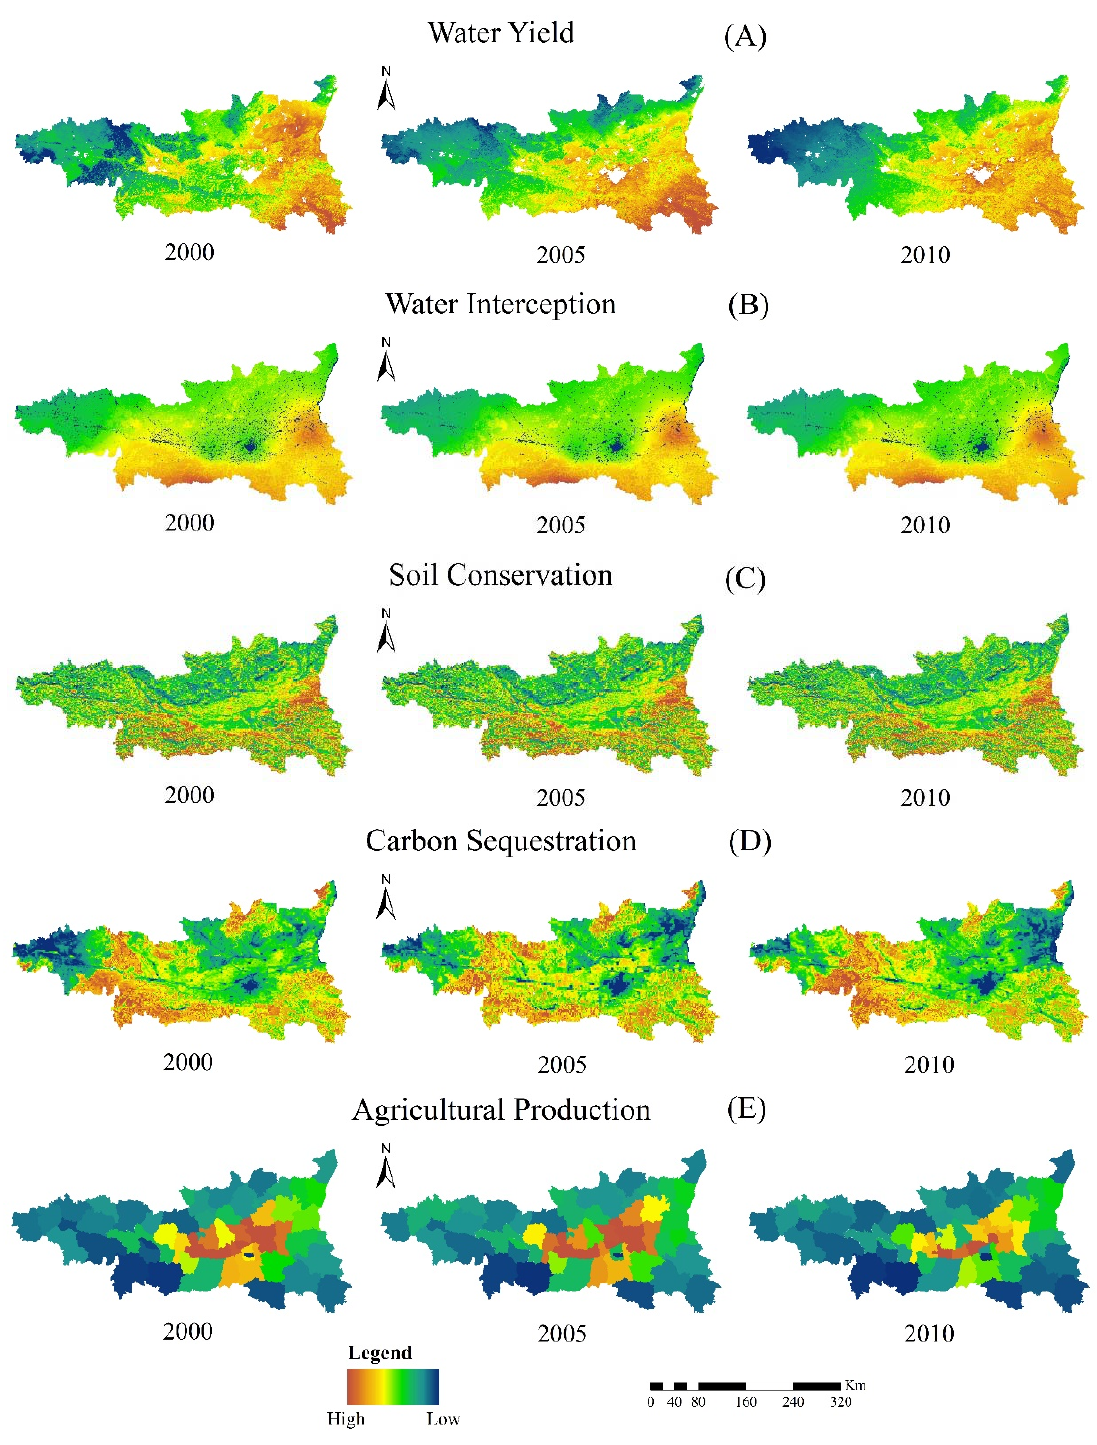
Figure 4. Maps of ecosystem services in the Guanzhong-Tianshui Economic